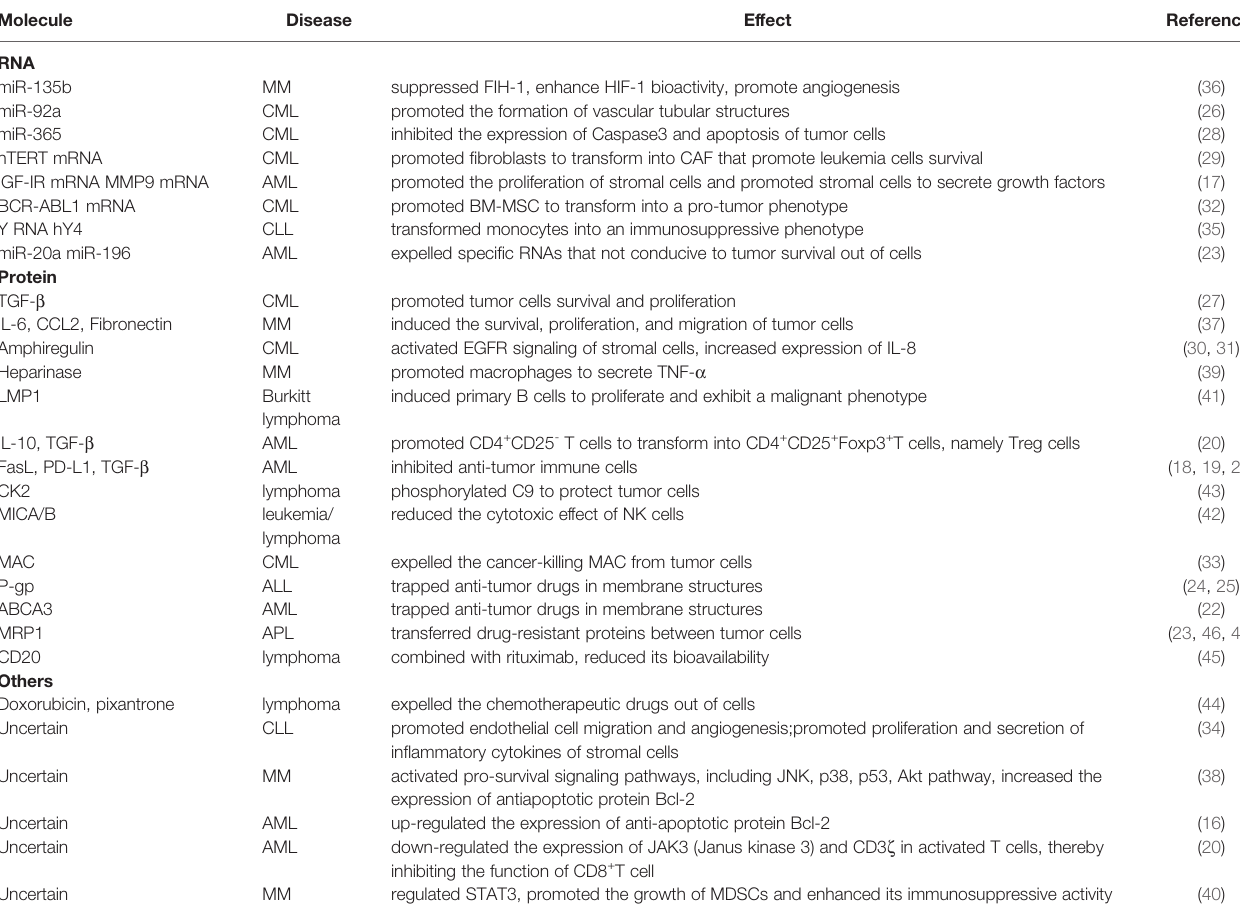
TABLE 2 | Exosome cargos and their function in tumor